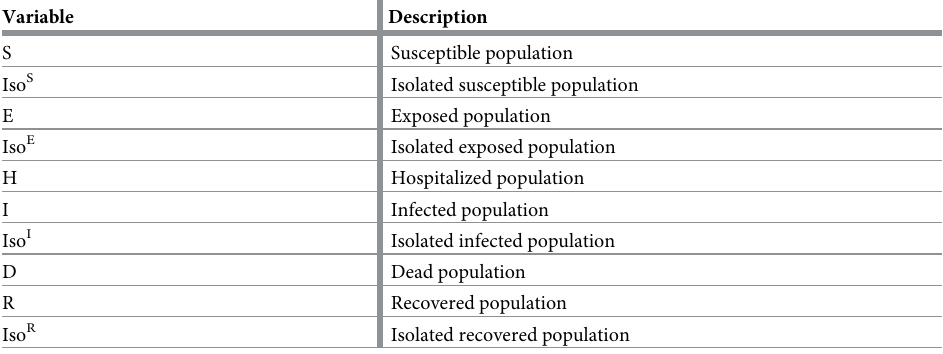
Table 1. Variables used in the compartmental